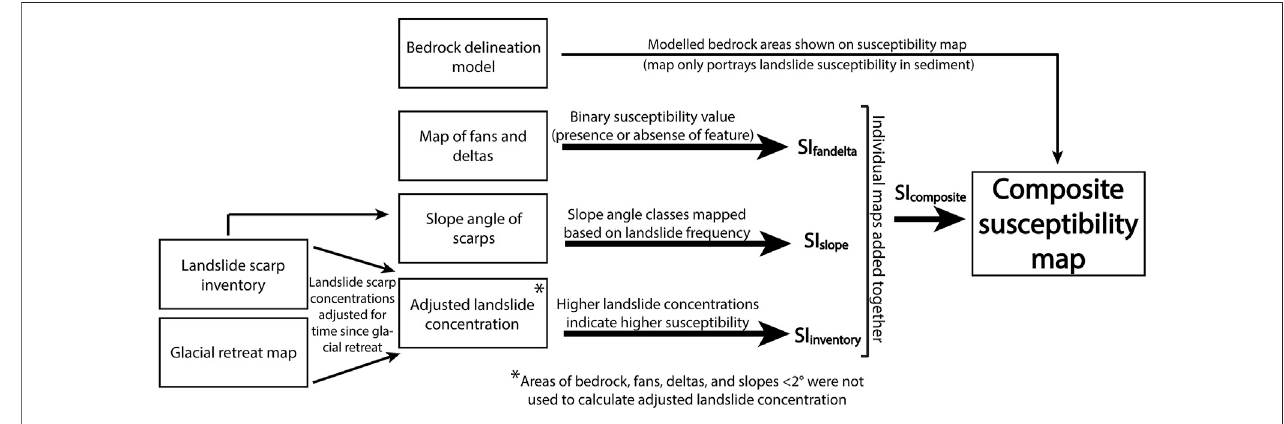
FIGURE 6 | Flow chart showing the work fl ow of the